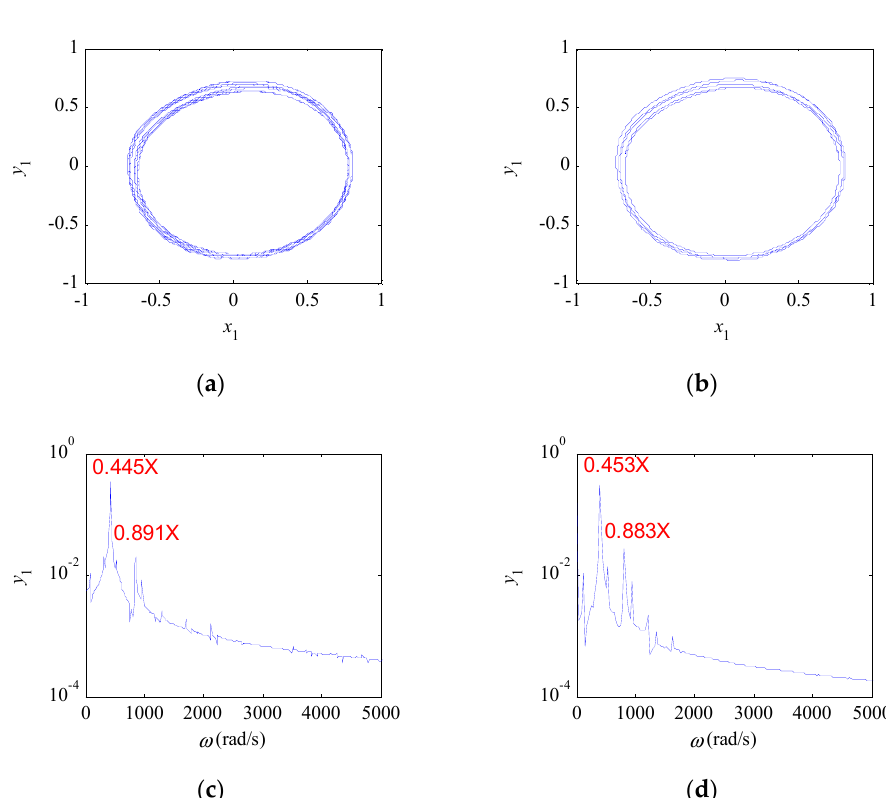
Figure 6. Comparisons between POM of 2-DOFs obtained by the optimal sampling length at ω = 350 rad/s and original system(O-S) for axis orbit and frequency spectrum at ω = 950 rad/s: ( a ) axis orbit of O-S, ( b ) axis orbit of POM, ( c ) frequency spectrum of O-S, ( d ) frequency spectrum of POM.